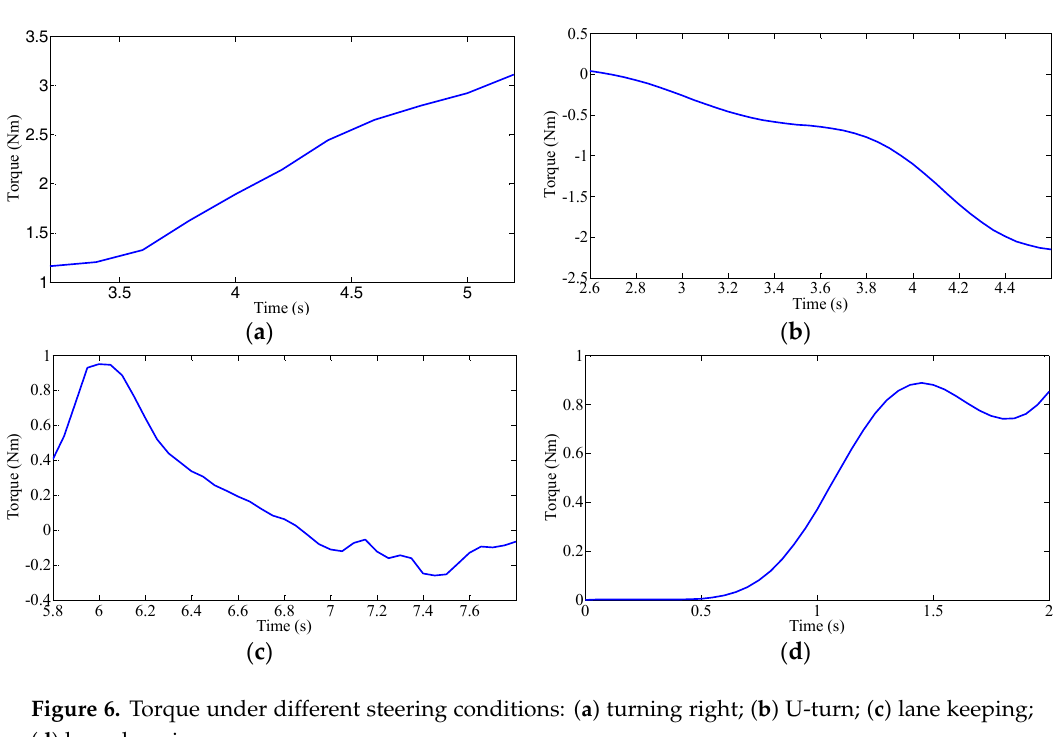
Figure 6. Torque under different steering conditions: ( a ) turning right; ( b ) U-turn; ( c ) lane keeping; ( d ) lane changing.